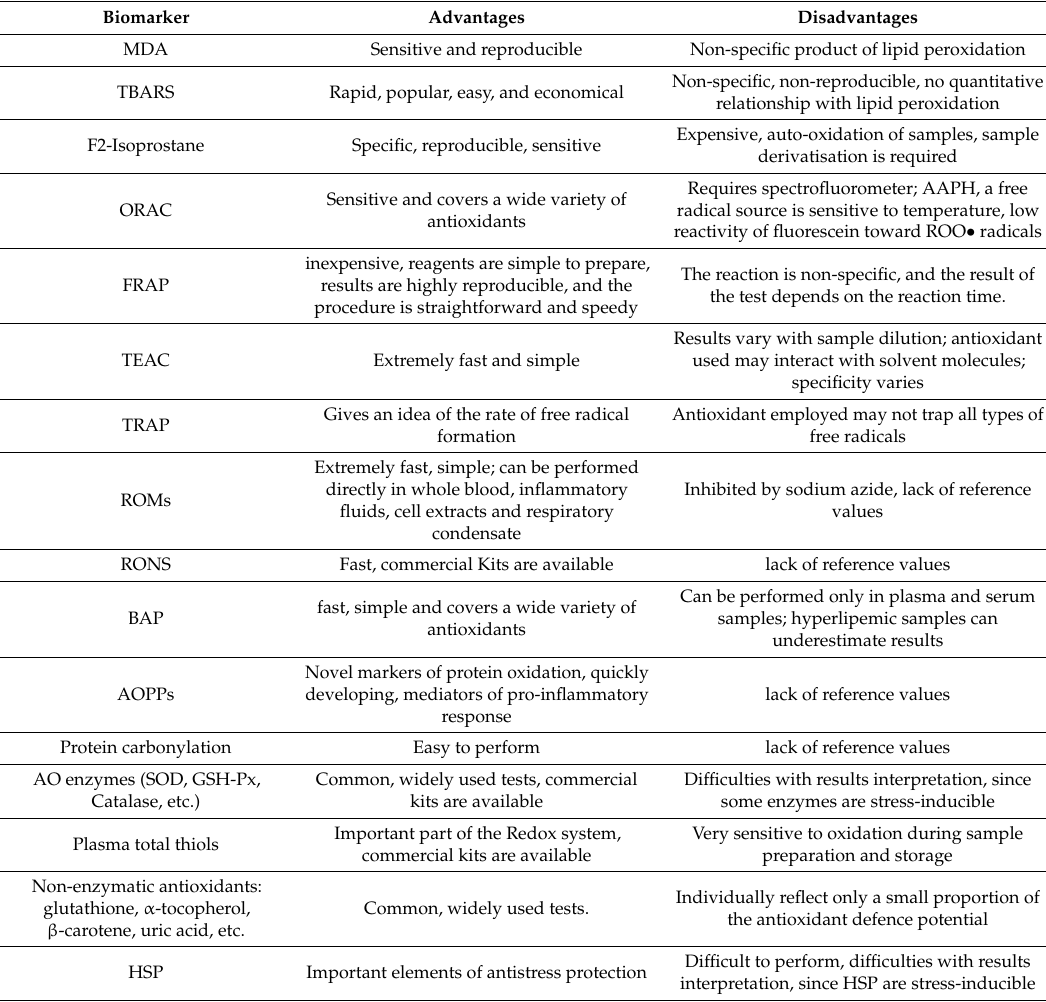
Table 2. Advantages and disadvantages of various biomarkers as indicators of oxidative stress in ruminants (Adapted from